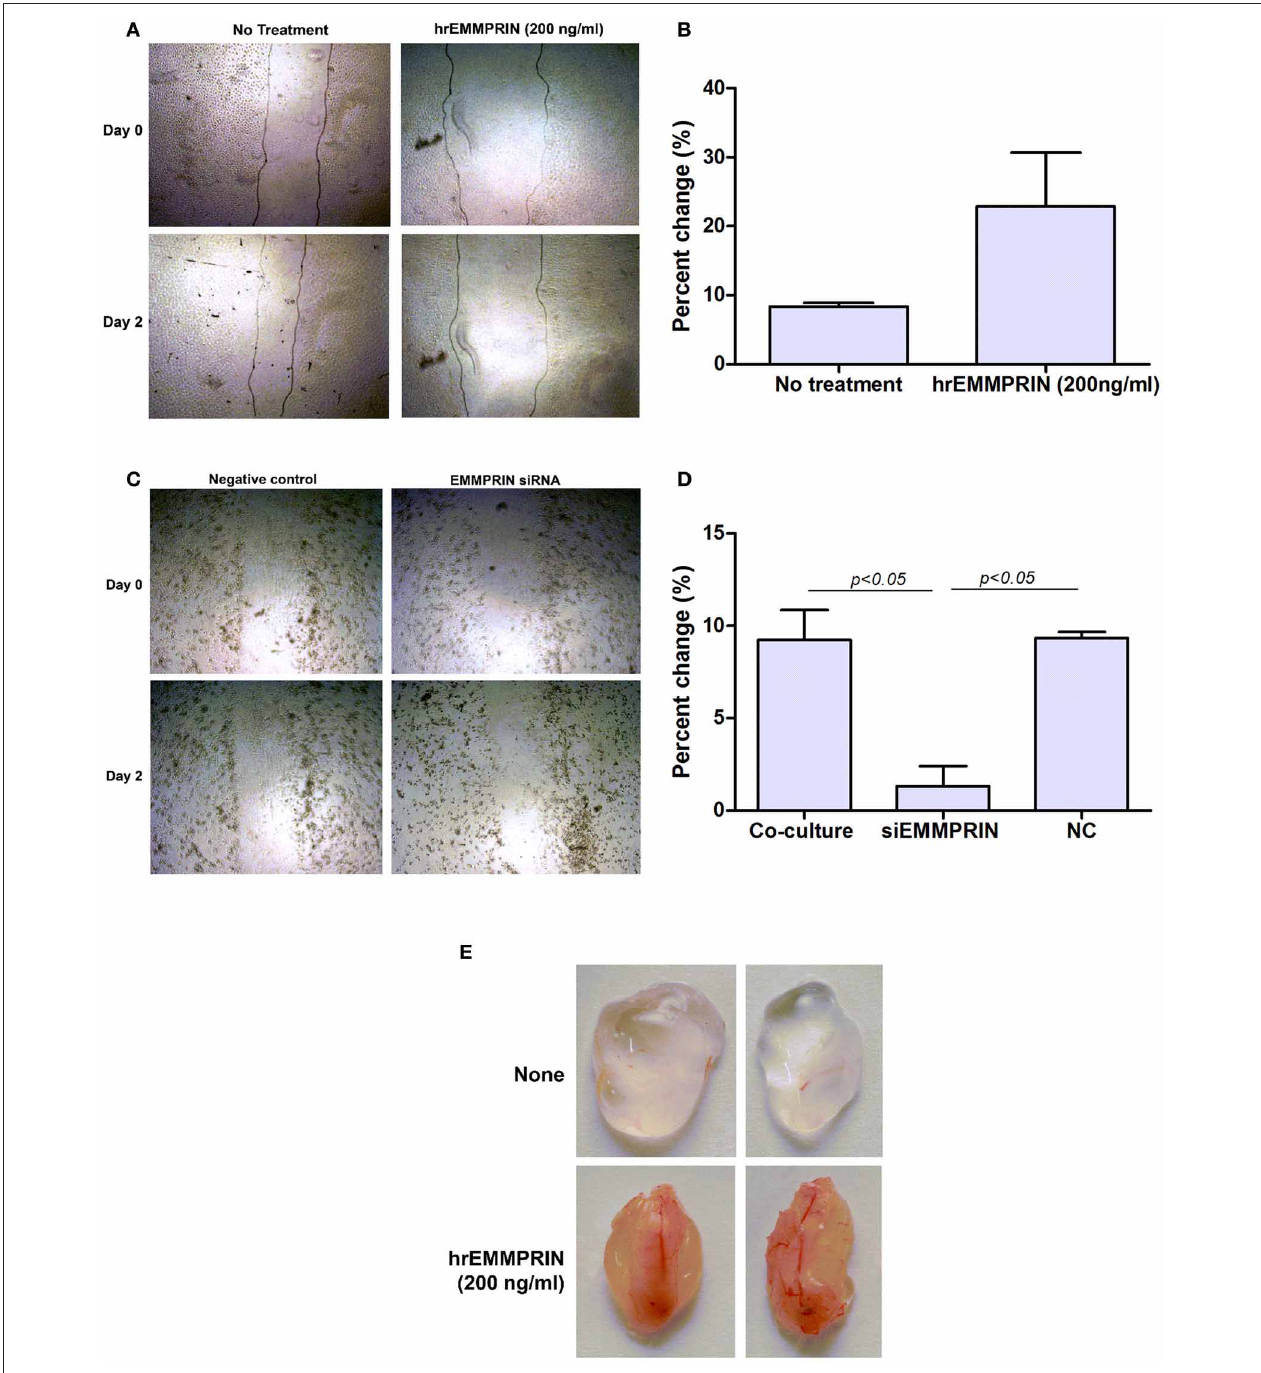
FIGURE 10 | Soluble EMMPRIN has pro-angiogenic properties. 2 × 10 6 Eahy926 cells were grown to confluency in 24-well plates, and a wound assay was performed by making a scratch, as described in the methods. (A) A representative photograph of the scratched area in a wound assay at the beginning (0h) and at the end (48h) of the experiment (magnification X40) while adding recombinant EMMPRIN (200ng/ml). Gray lines depict the cell front. (B) Rate of wound closure was measured by comparing the distance between the two sides of the scratch using